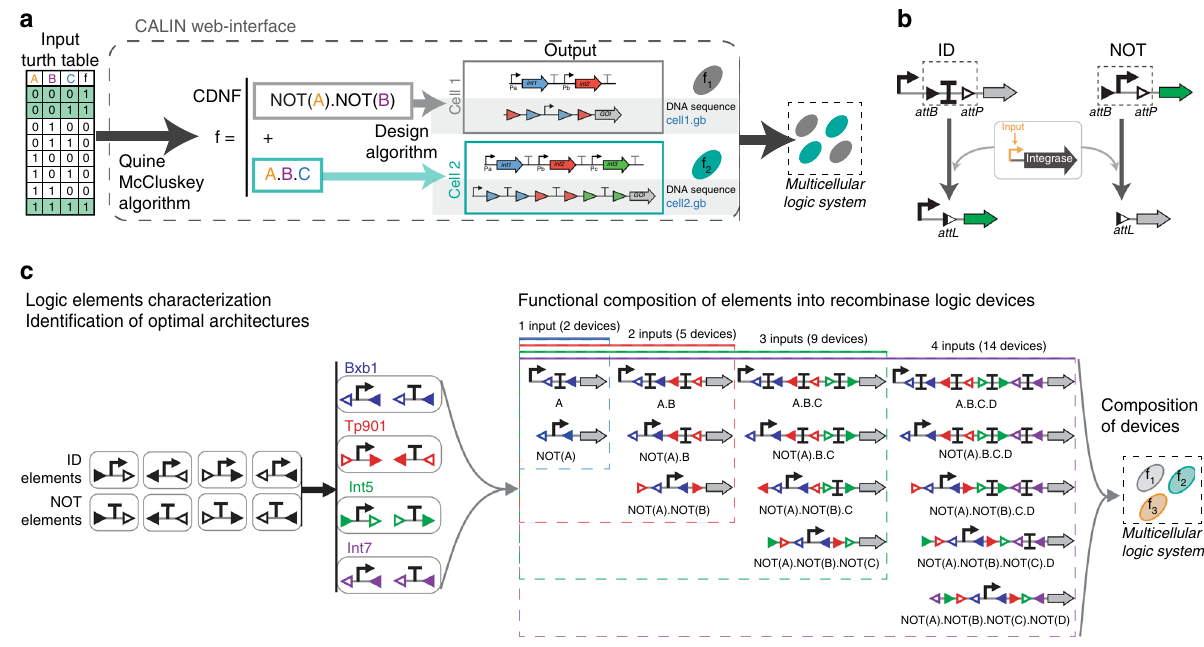
Fig. 1 A hierarchical composition framework for recombinase logic design and engineering. a Design pipeline for multicellular recombinase logic. b Logic devices are built from NOT and IDENTITY (ID) elements, respectively composed by being nested or placed in series 17 . NOT elements are composed of a promoter surrounded by integrase sites. In presence of the integrase, the promoter is excised and expression of the output gene is switched from ON to OFF. IDENTITY elements are composed of a terminator surrounded by integrase sites. In presence of the integrase, the terminator is excised, and gene expression is switched ON. c Work fl ow for engineering reliable recombinase logic devices. ID and NOT elements with all possible integrase- site orientations and permutations are characterized (black triangle: attB site, white triangle: attP site). Elements with the best behavior are selected and composed to design the 14 logic devices required to compute all 4-input Boolean functions. For recombinase logic devices, blue sites (Bxb1 sites) correspond to input A, red sites (TP901-1) to input B, green sites (Int5) to input C and purple sites (Int7) to input